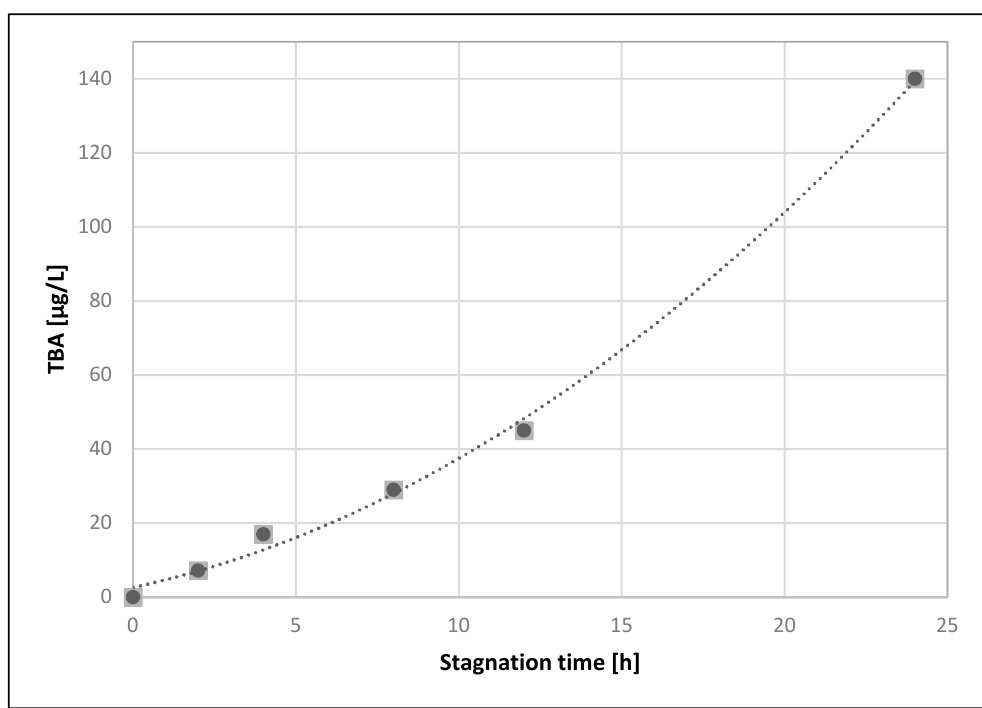
Figure 6. The amount of migration of tert-butyl alcohol into drinking water as a function of stagnation time.